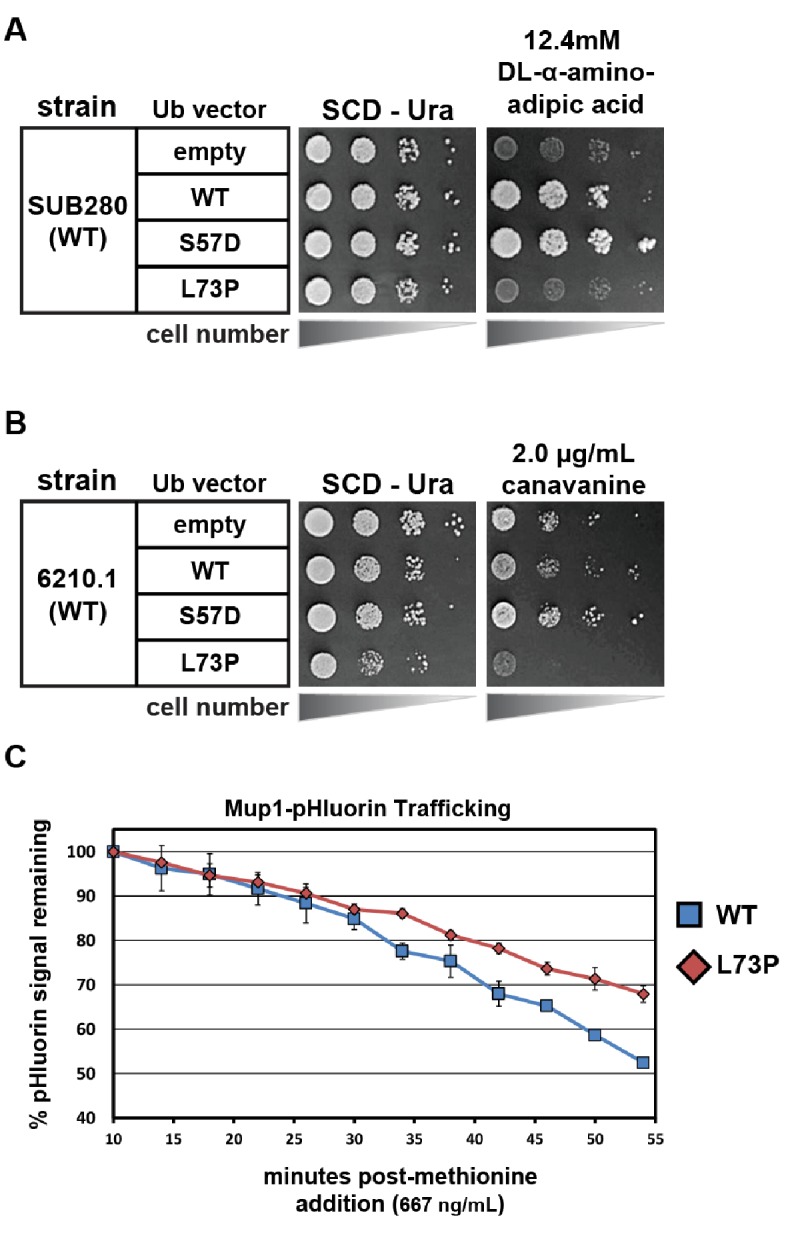
Phenotypic analysis of yeast cells expressing Leu73Pro ubiquitin.(A) SUB280 yeast cells (expressing ubiquitin from a single pLYS source plasmid) were transformed with a second ubiquitin-expressing plasmid (pURA) and grown in the presence of DL-α-aminoadipic acid to counterselect against the pLYS plasmid (‘plasmid shuffle’). (B) Wildtype yeast cells (SEY6210.1 background) transformed with either empty vector or plasmids expressing ubiquitin (wildtype, S57A or L73P) from the ADH1 promoter were plated on minimal media with or without canavanine. (C) Wildtype yeast cells expressing pHluorin-tagged Mup1 (SEY6210.1 background) transformed with either empty vector or plasmids expressing ubiquitin (wildtype, S57A or L73P) from the ADH1 promoter were monitored using flow cytometry measurements of pHluorin signal in a time course following methionine stimulation.